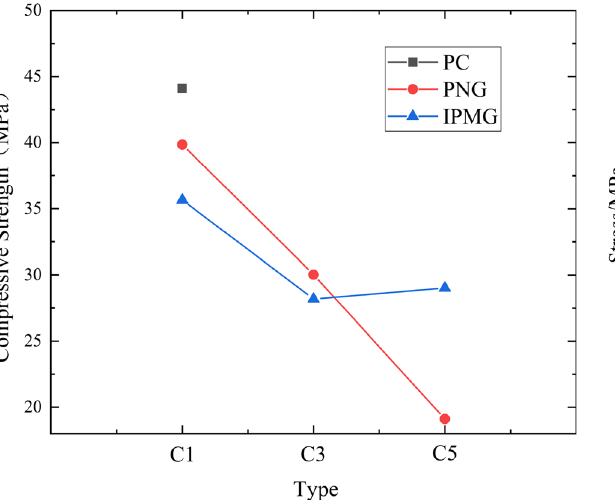
Figure 6: Compressive test results.